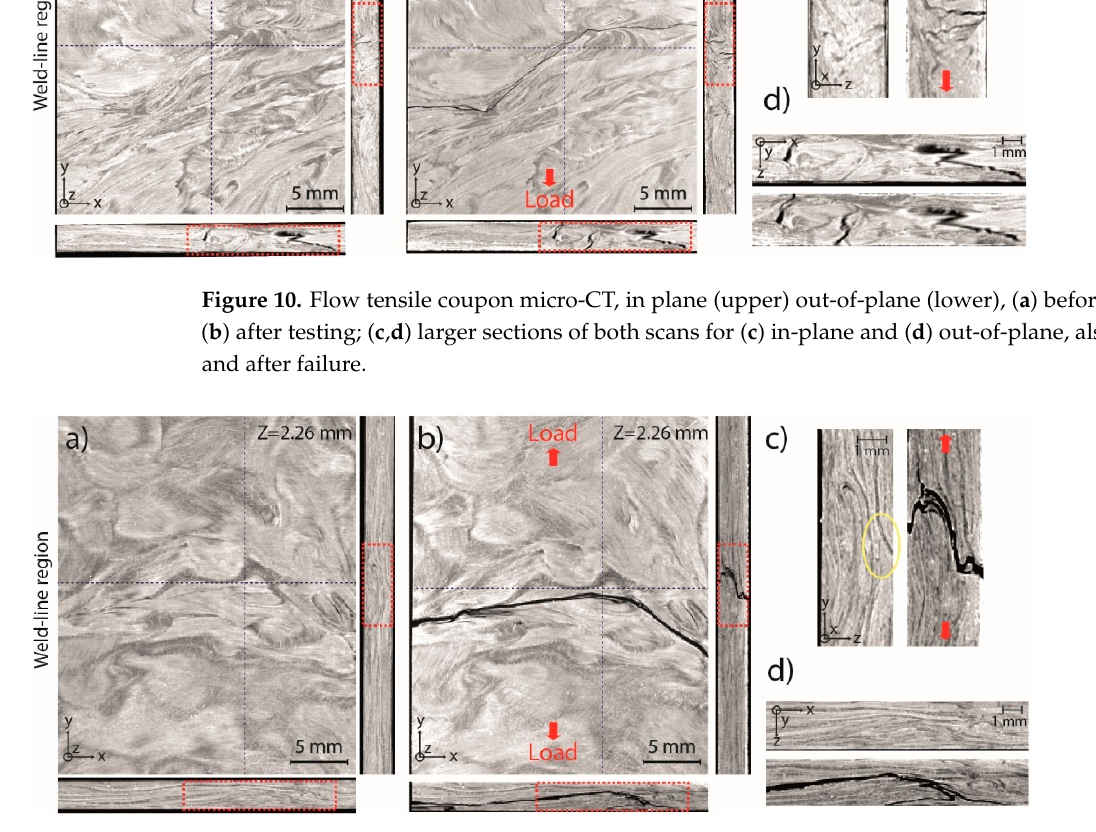
Figure 10. Flow tensile coupon micro-CT, in plane (upper) out-of-plane (lower), ( a ) before testing; ( b ) after testing; ( c , d ) larger sections of both scans for ( c ) in-plane and ( d ) out-of-plane, also before and after failure.